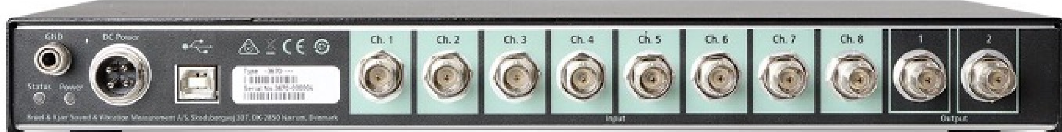
Figure 7. Bruel & Kjær Type 3670 Data Acquisition